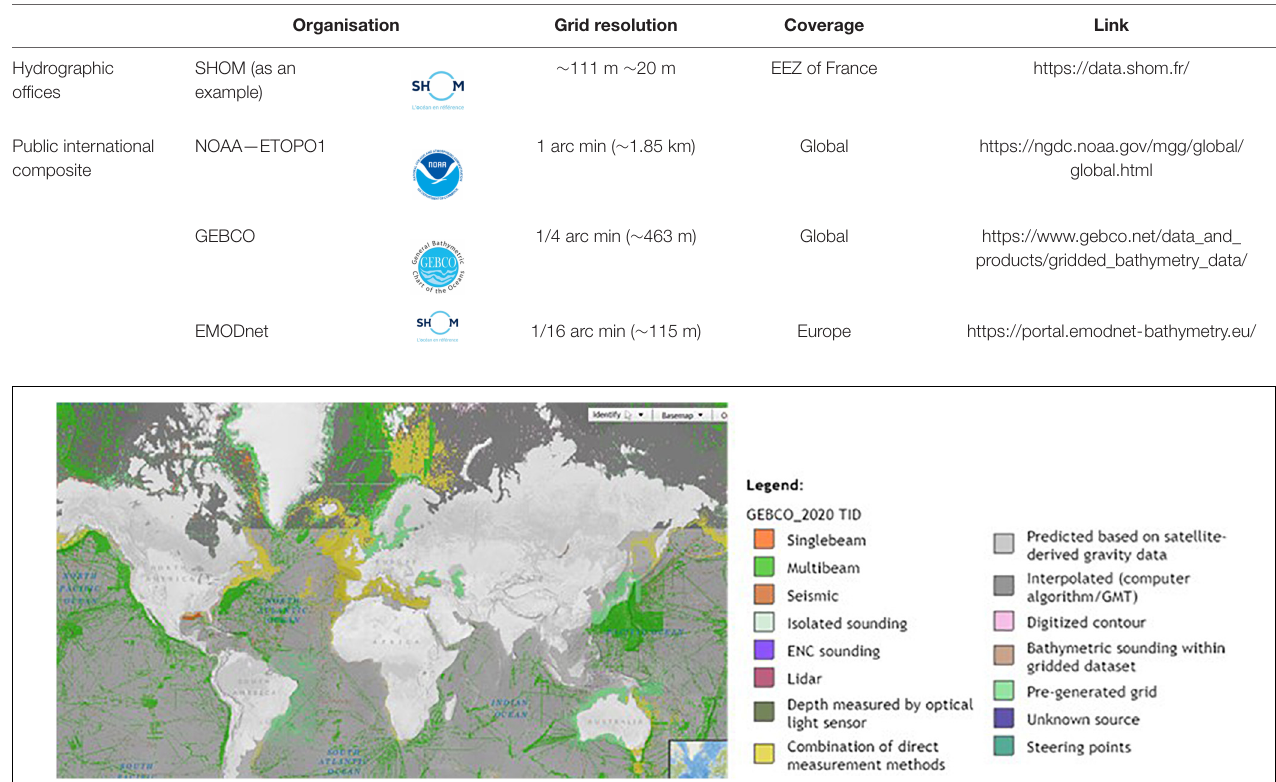
TABLE 1 | Examples of public available bathymetric digital grids.